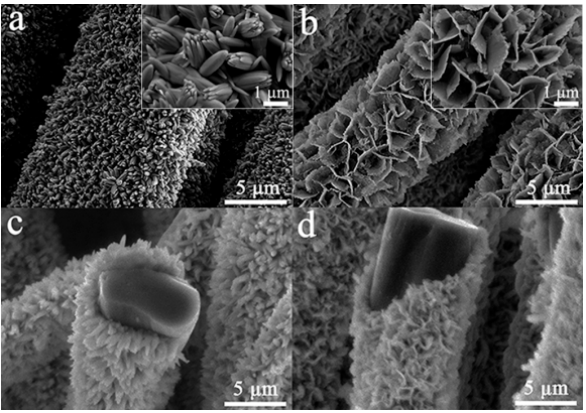
Figure 1. Surface morphology of as-prepared samples: ( a ) MHP bouquet arrays/ACF (the inset figure is magnified image of given sample); ( b ) MHP nano-sheet arrays/ACF (the inset figure is magnified image of given sample); ( c ) the image of MHP bouquet arrays/ACF’s cross section; ( d ) the image of MHP nano-sheet arrays/ACF’s cross section.